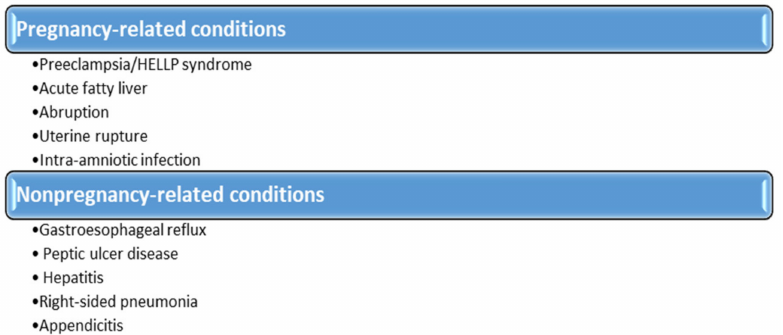
Figure 3. Differential diagnosis of